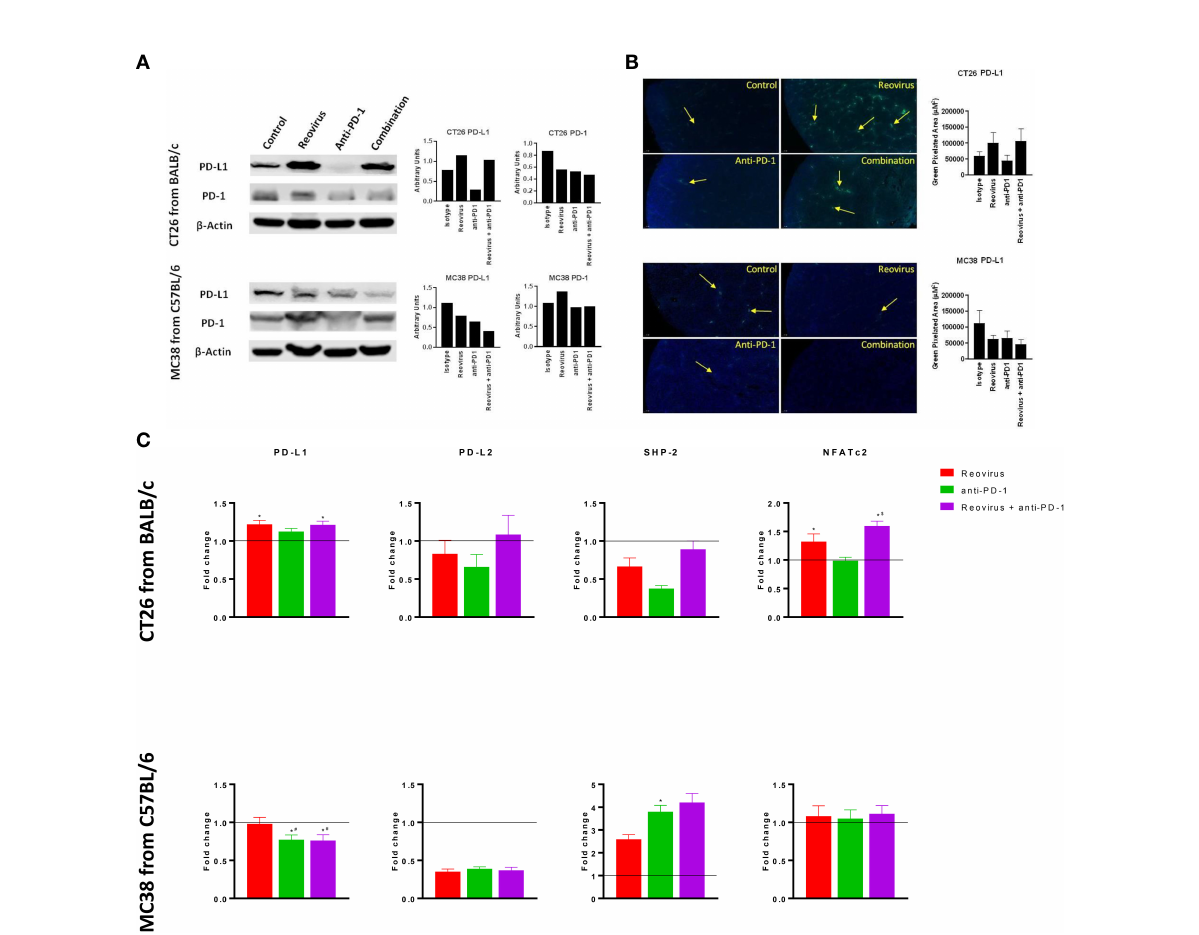
FIGURE 5 Differential signaling of PD-L1/PD-1 axis in CT26 and MC38 tumor milieu. (A) Single agent reovirus treatment increased (p=0.04) or unaltered PD-L1 protein expression and unaltered or increased (p=NS) of PD-1 in CT26 and MC38 tumors, respectively. Trends in expression also reversed in both models upon combination treatment, however, signi fi cance observed only for PD-L1 (p=0.03; CT26, and p=0.04; MC38) (Western Blot analysis). (B) Representative immuno fl uorescence images of PD-L1 expression among CT26 and MC38 tumors. PD-L1 protein localization and expression signi fi cantly increased upon reovirus (p=0.03) and its combination with anti-PD-1 treatment (p=0.04) in CT26. While the expression was unaltered with single agent treatments, combination reduced (p=0.05) PD-L1 in MC38 tumors. (C) Transcriptional level changes in expression of key mediators of PD-L1/PD-1 signaling. Combination treatment increased the fold difference in expression of PD-L1 (p=0.04), PD- L2, SHP-2 and NFATc2 (p=0.03) in CT26 and SHP-2 in MC38. Combo decreased PD-L1 (p=0.03) and unaltered PD-L2 and NFATc2 expression in MC38 tumors. Fold difference was comparatively low for all genes investigated under single agent anti-PD-1 treatment in CT26, and PD-L1 alone in MC38, where the expression indeed reduced (p=0.03). Data were shown as mean±SEM; n=5; * p ≤ 0.05, compared with control group; # p<0.05 compared with reovirus group; $ p ≤ 0.05, compared with anti-PD-1